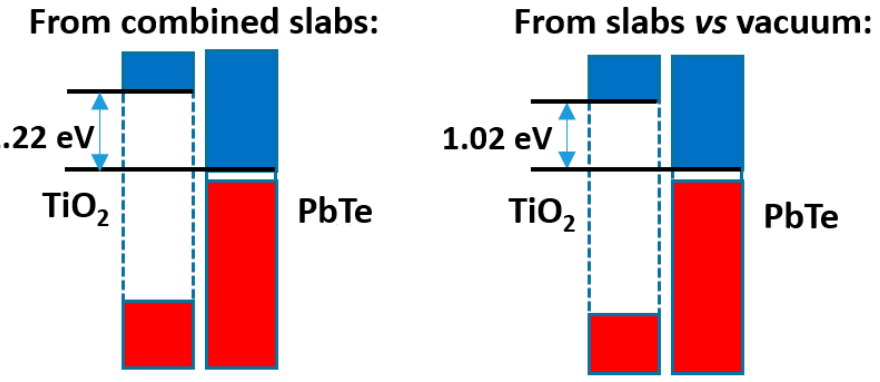
Figure 9. Band offsets found for the rutile TiO 2 |PbTe case.